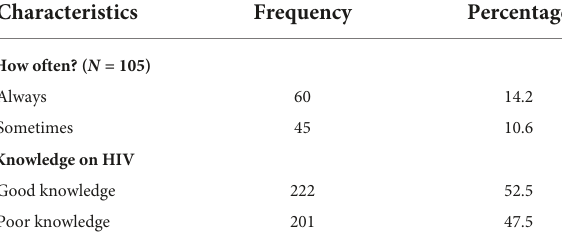
TABLE 2 Obstetrics and clinical and partnership characteristics of study participants in the Amhara Region Referral Hospitals, Ethiopia, 2020/2021 ( n =